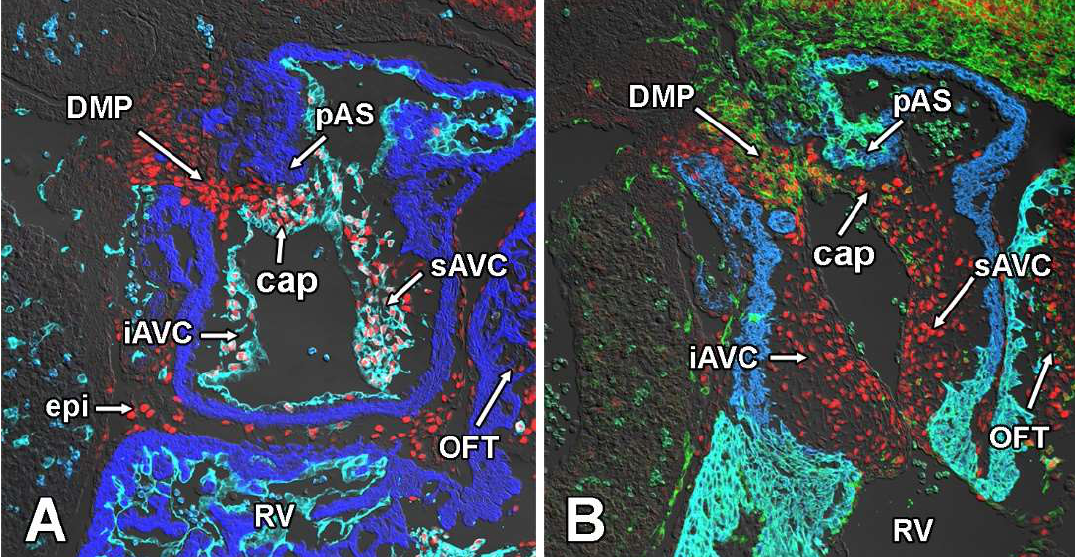
Figure 5. Sox9 expression in the mesenchymal cap and DMP at embryonic day 11.5. Panels A and B show sagittal sections of Nfactc1cre;R26mG ( A ) and SHFcre;R26mG ( B ) embryonic hearts at ED11.5. The section in panel ( A ) was stained for GFP (light green) to delineate endocardial and endocardiallyderived cells, Myosin Heavy Chain (dark blue), and Sox9 (red). The section in panel ( B ) was stained for GFP (green) to delineate SHF and SHF-derived cells, Myosin Heavy Chain (blue), and Sox9 (red). Both sections show how the respective components of the AV mesenchymal complex (cap, AV cushions, and DMP) are contiguous and how the Sox9 expressing mesenchyme of AV cushions and cap is endocardially derived ( A ). The SHF-derived mesenchyme of the DMP expresses Sox9 at this stage ( B ) cap = mesenchymal cap, DMP = dorsal mesenchymal protrusion, epi = epicardium, iAVC = inferior AV cushion, sAVC = superior AV cushion, OFT = outflow tract, pAS = primary atrial septum, RV = right ventricle.